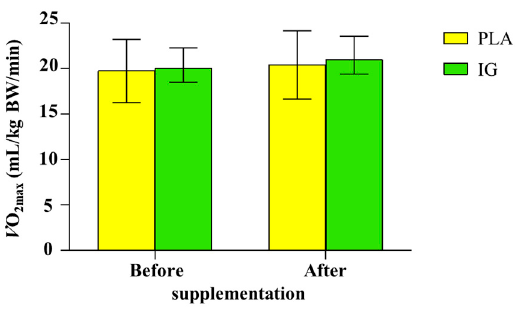
Figure 6. Aerobic capacity (mL/kg BW/min) of the participants tested using incremental exercise test. The bar graph presents mean ± SD (n = 33 each group). Abbreviations: PLA, placebo; IG, Irvingia gabonensis.